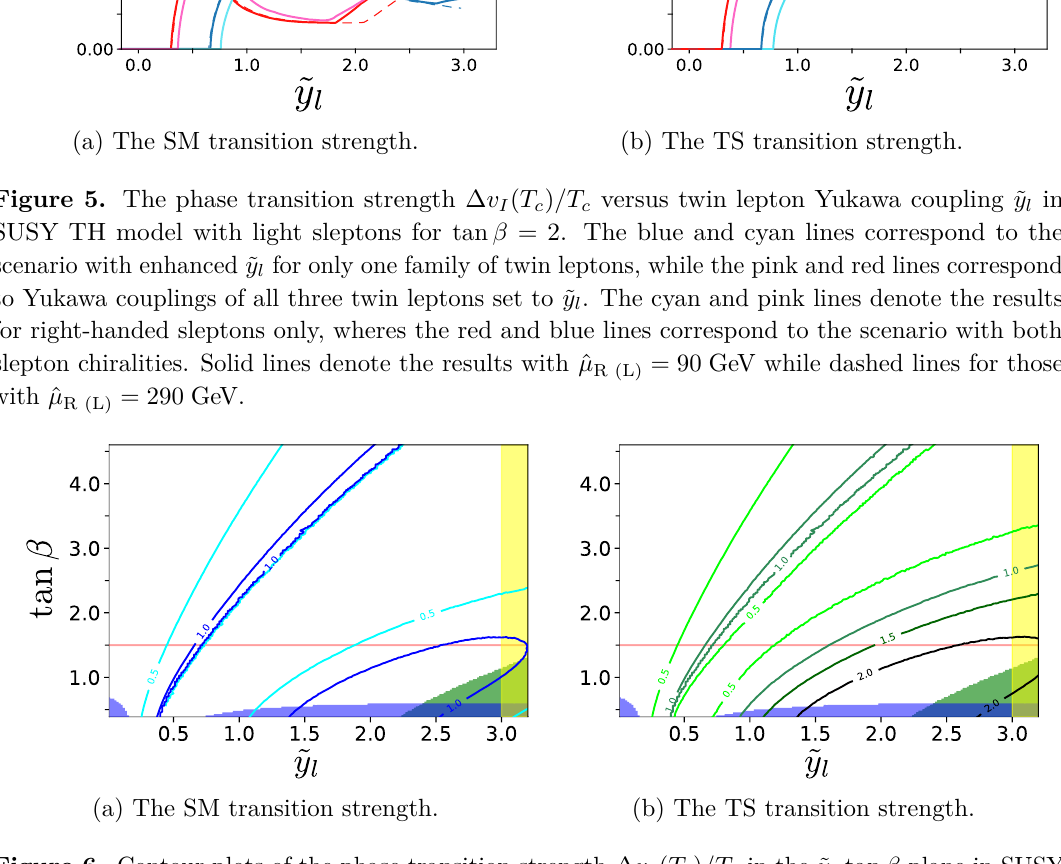
Figure 6. Contour plots of the phase transition strength ∆ v I ( T c ) /T c in the ˜ y l - tan β plane in SUSY TH model with light right- and left-handed sleptons from all three families. The soft slepton masses were set to µ sl = ˆ µ sl = 100 GeV. In accordance with MSSM RGEs the Landau pole of the top Yukawa appears below 10 16 GeV if tan β . 1 . 5 (region under the red line). We cut the plot at tan β = 0 . 4 since for smaller tan β values the Landau pole would appear below 10 4 GeV. In the yellow region a Landau pole for the twin lepton Yukawa coupling appears below 10 f 0 . In the blue region the MSSM slepton mass squared was found negative at some point of the thermal